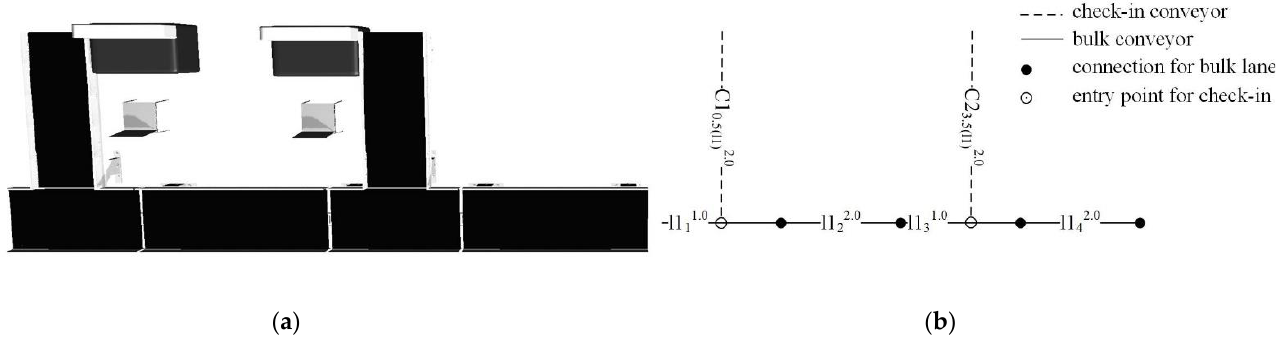
Figure 2. Example of system structure translation: ( a ) part of the modeled system, ( b ) system structure in model notation.